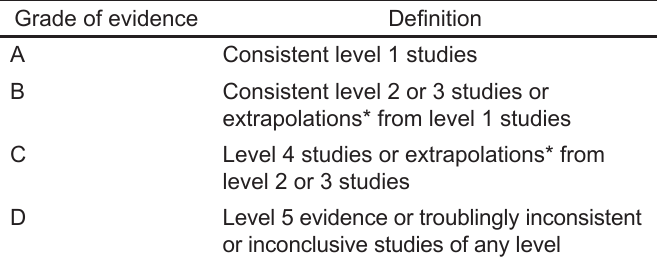
Table 1b. Oxford Centre for Evidence-Based Medicine grades of recommendation.